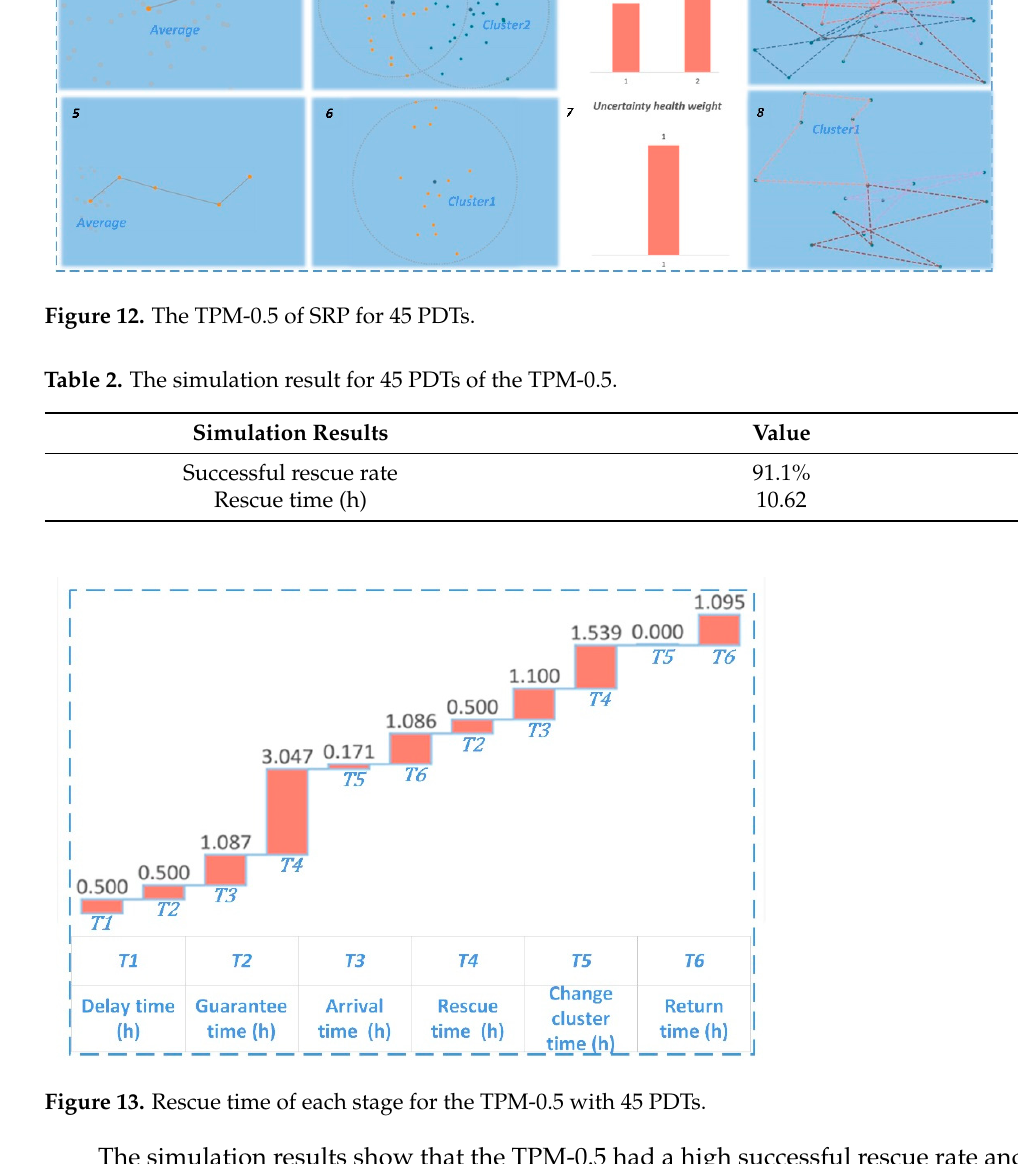
Figure 14. The box line diagram of the successful rescue rate and the rescue time for the TPM-0.5. The average rescue times for each stage of the TPM-0.5 with 45 PDTs and 70 PDTs are shown in Figures 15 and 16. The meaning of 𝑇 (cid:3036) in Figures 15 and 16 is the same as that in Figure 13. The results show that the number of the amphibious aircraft transfer